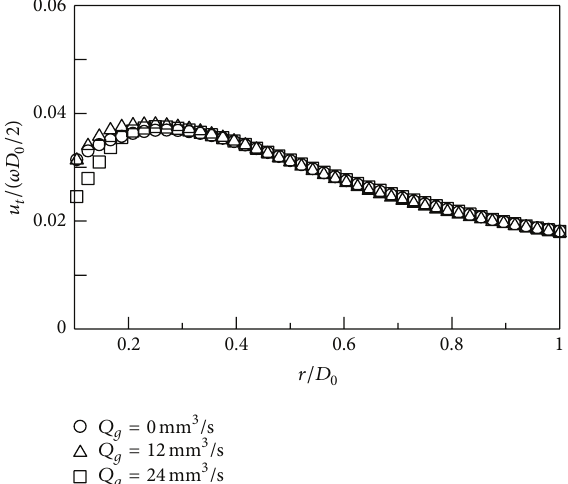
Figure 14: Change in circumferential velocity of water at 𝑧/𝐷 0 = 4.17 when Ω = 11.7 × 10 4